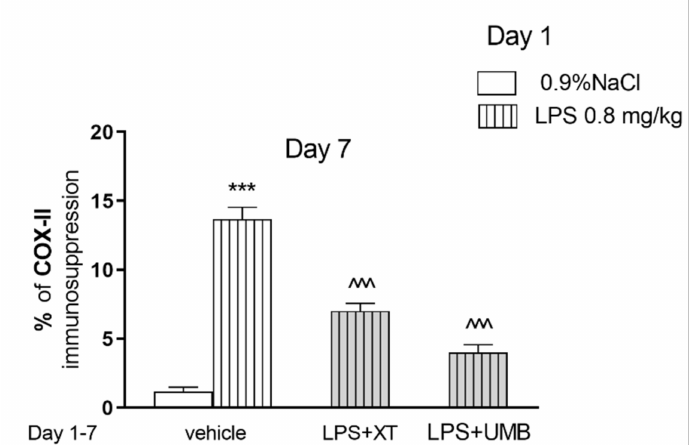
Figure 6. Effects of acute injection of LPS (0.8 mg/kg) and repeated xanthotoxin (XT, 15 mg/kg) and umbelliferone (UMB, 15 mg/kg) in combination on COX-2 immunosuppression in the hippocampus. LPS (0.8 mg/kg, i.p.) was administered on the day 1, XT and UMB were administered repeatedly (day 1–7). The brains were collected 24 h after the last injection; n = 3; the means ± SEM; *** p < 0.001 vs. saline-treated control group, ˆˆˆ p < 0.001 vs. LPS treated control group; Tukey’s test.